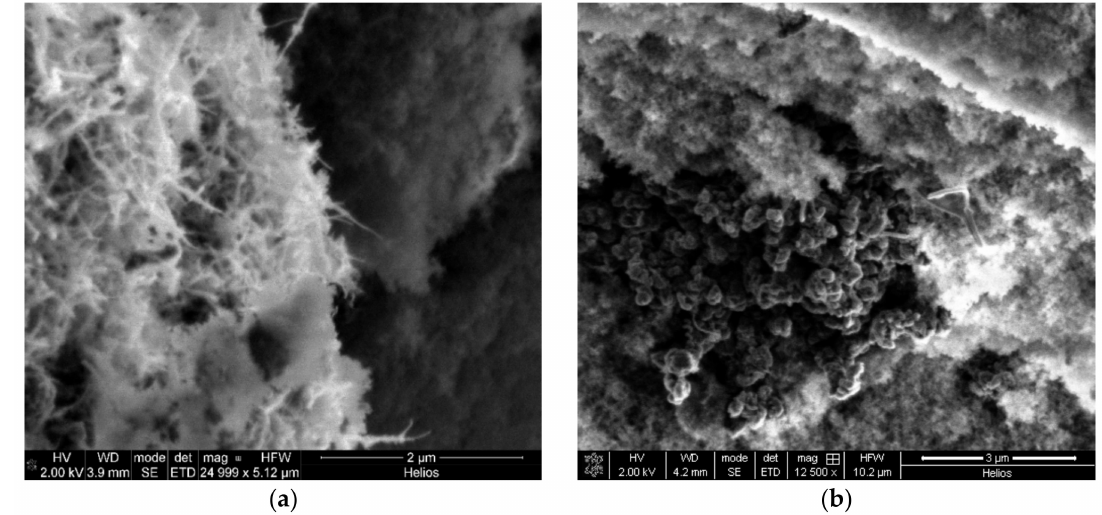
Figure 5. SEM image of silica–CNT hybrid aerogel: ( a ) microparticles with a CNT weight percentage of 4.5 wt.%; ( b ) aggregation of CNTs.